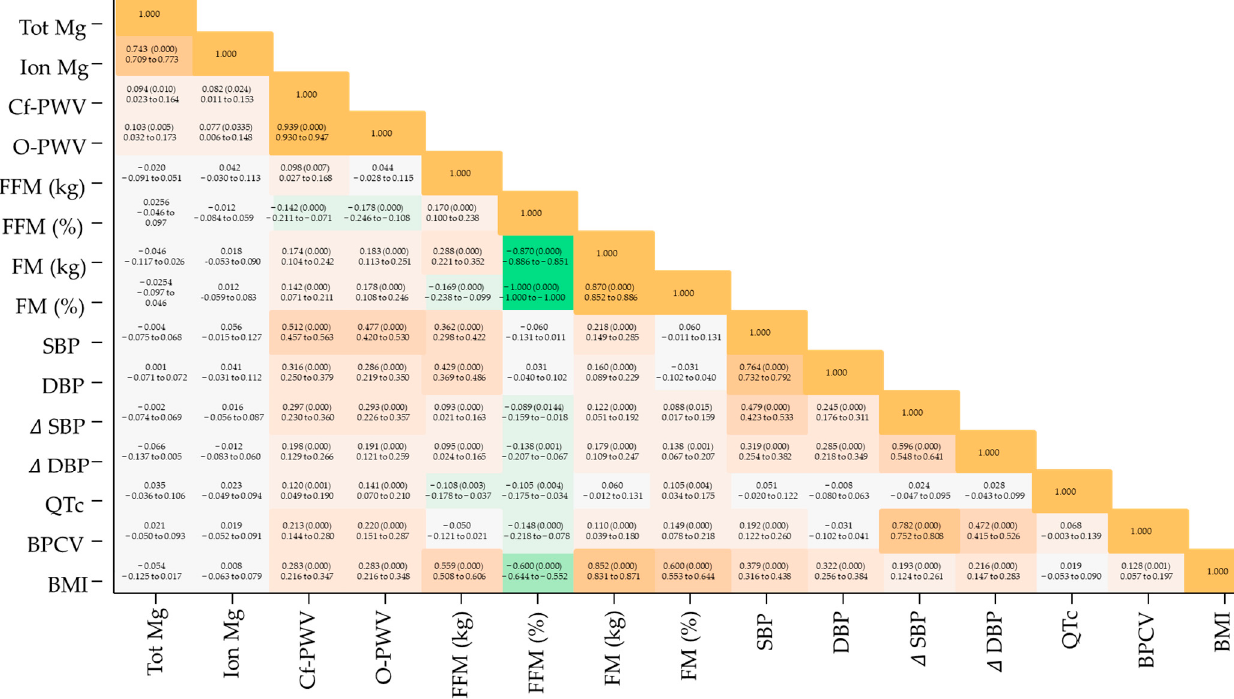
Figure A2. Correlations between measured parameters. Correlation coefficients ( p -value when <0.05) and 95% CI are reported. Tot Mg, total magnesium; Ion Mg, ionized magnesium; Cf-PWV, carotid-femoral pulse wave velocity (SphygmoCor device); O-PWV, brachial pulse wave velocity (Mobil-O-Graph device); FFM, free fatty mass; FM, fatty mass; SBP, systolic blood pressure; DBP, diastolic blood pressure; Δ SBP, delta maximum–minimum values; Δ DBP, delta maximum–minimum values; BPCV, blood pressure coefficient of variation; BMI, body mass index. The color orange indicates a positive correlation; the color green indicates a negative correlation. The degree of color intensity reflects the degree of correlation (more faded, less intense correlation, and vice versa).